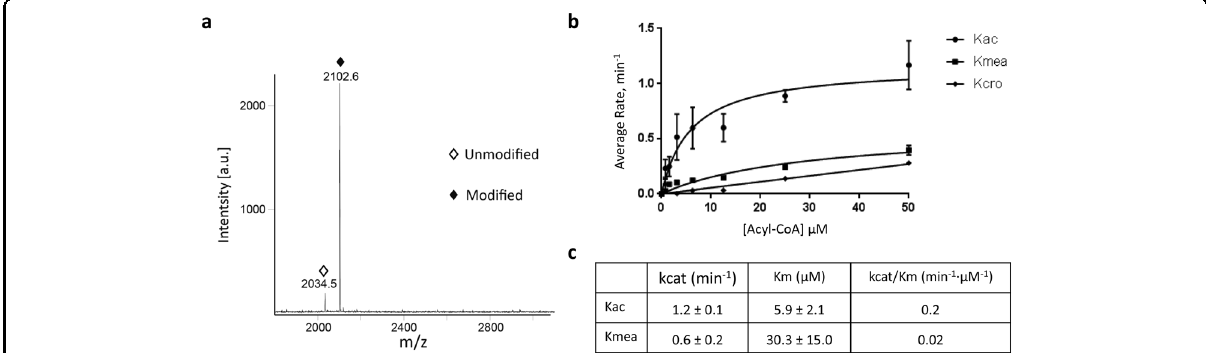
Fig. 5 HAT1 catalyzes Kmea addition in vitro. a Synthetic peptides consisting of the fi rst 20 amino acid residues of the H4 histone, H4 (1-20), were incubated with methacrylyl-CoA and recombinant HAT1 in vitro. MALDI-TOF analysis detected unmodi fi ed (open diamond) and methacrylated (solid diamond) peptides. b HAT1 was incubated with acetyl-CoA, methacrylyl- CoA, or crotonyl-CoA at varied concentrations and H4 (1-20) peptide substrates for 15 min, respectively. The enzymatic reaction was quanti fi ed using 7-diethylamino-3-(4 ’ -maleimidylphenyl)-4-methylcoumarin (CPM) assay. c The reaction rate-acyl-CoA concentration was plotted with the Michaelis-Menten equation to get the kinetic constants Km and kcat for acetyl-CoA and methacrylyl-CoA substrates, respectively. The kcat/Km values were used to evaluate lysine acylation ef fi